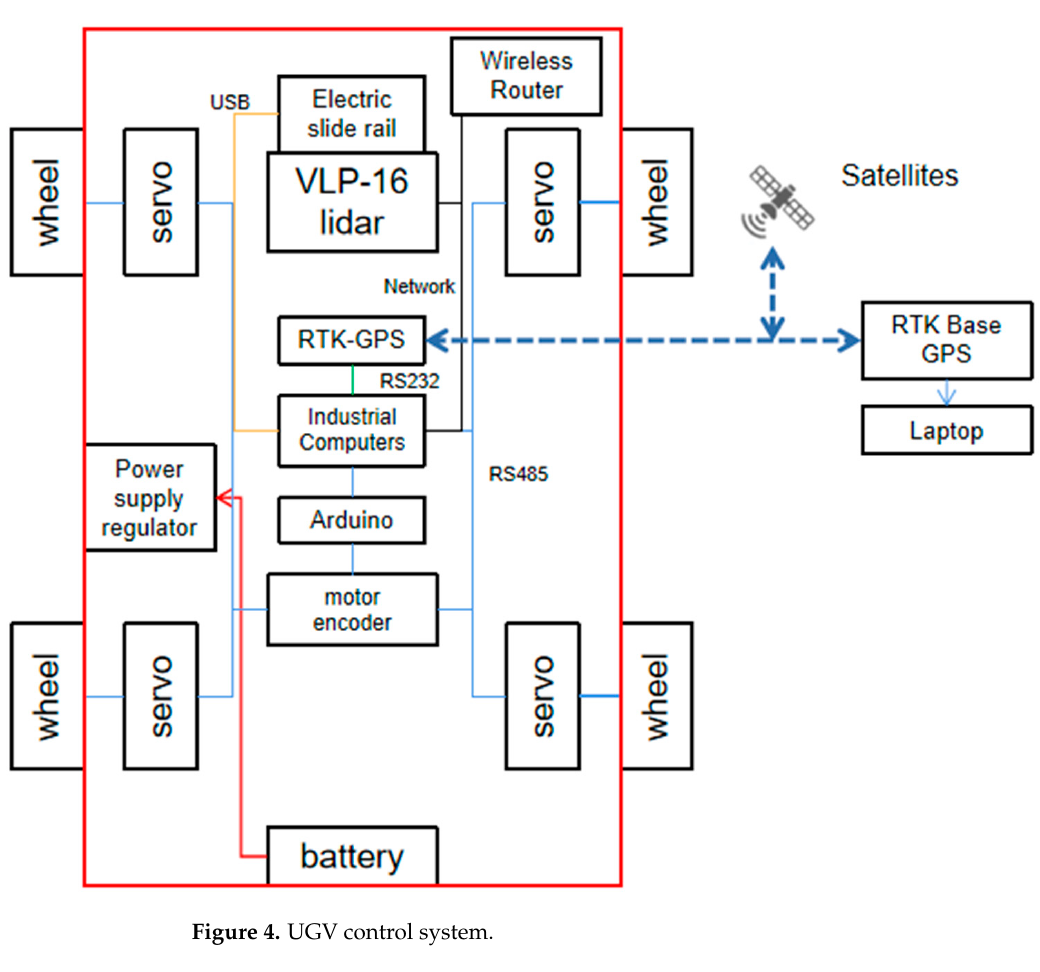
Figure 4. UGV control system.